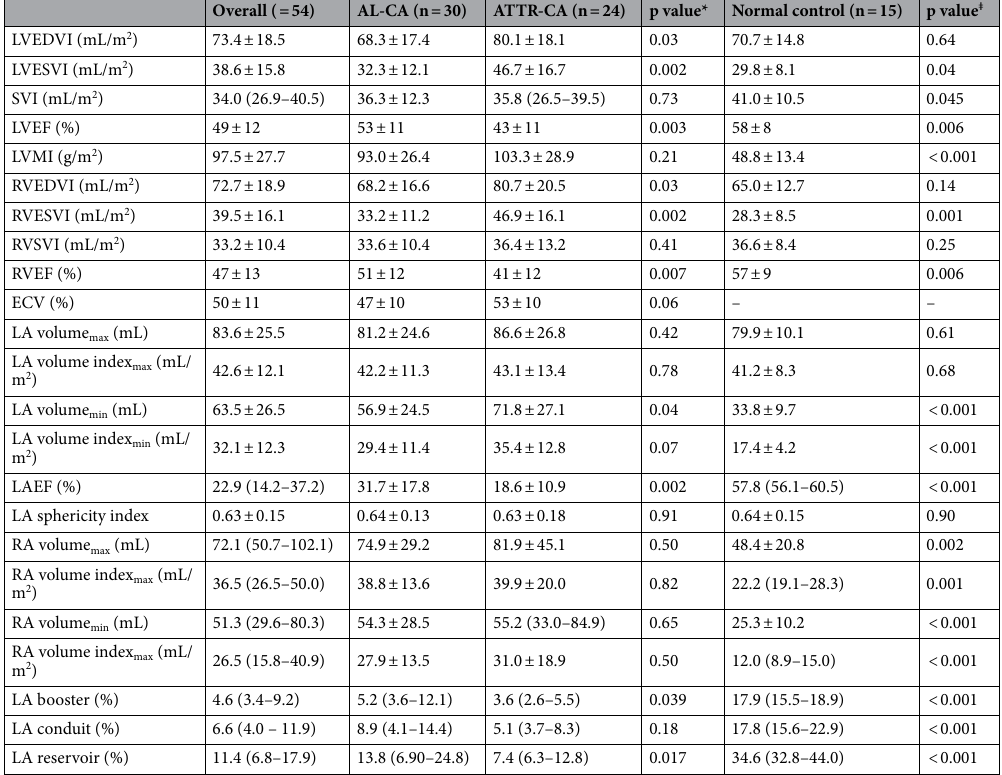
Table 2. CMR Characteristics. Continuous variables are expressed as mean ± standard deviation or median (interquartile range). Categorical variables are presented as n (%). LV left ventricular, RV right ventricular, LVEDVI left ventricular end-diastolic volume index, LVESVI left ventricular end-systolic volume index, SVI stroke volume index, EF ejection fraction, RVEDVI right ventricular end-diastolic volume index, RVSVI right ventricular end-systolic volume index, LA left atrial, ECV extracellular volume, EF ejection fraction, RA right atrial. *AL-CA vs. ATTR-CA. ǂ CA vs. Normal